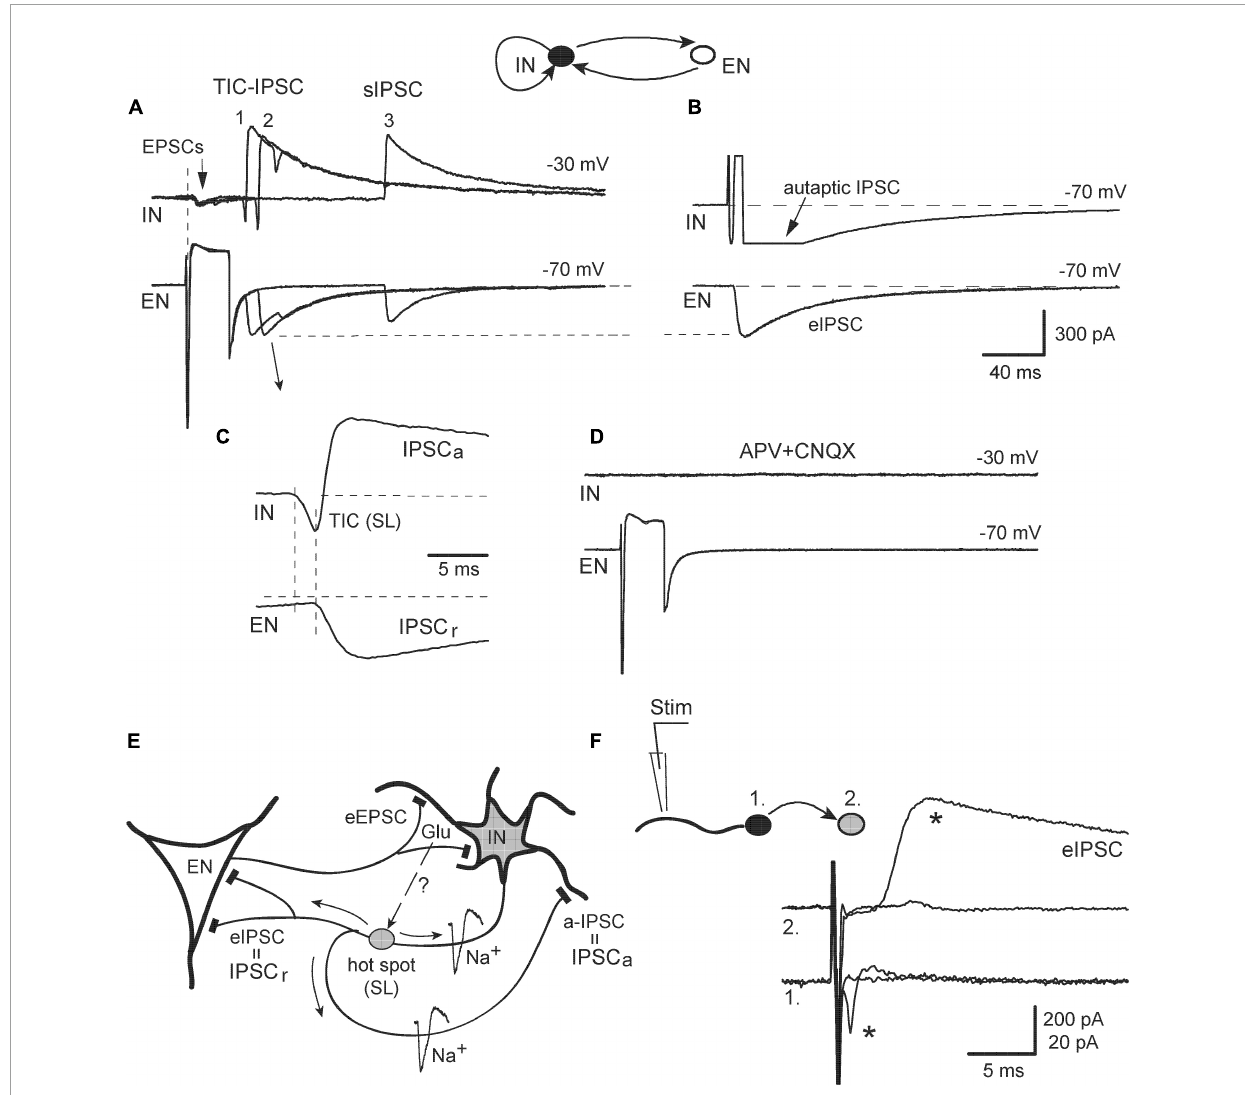
FIGURE7 Example of the electrical behavior of excitatory-inhibitory cell circuit. (A) Presynaptic stimulation of EN induced three kinds of postsynaptic responses (three of them were superimposed): monosynaptic EPSCs ( arrow ), remote sequences TIC-IPSC ( 1 , 2 ), and late sIPSC ( 3 ). (B) Stimulation of IN evoked IPSC in EN and autaptic IPSC in itself (it was blocked by BMI). (C) TIC-IPSC sequence #2 was expanded to show its intrinsic temporal relations (see Text for details). (D) The application of APV + CNQX blocked all responses. (E) Schema describing electrical behavior of EN-IN pair. TICs appeared as local spikelets ( SL ); they originated in axonal hot spots and induced both autaptic IPSC ( a-IPSC ) and eIPSC in EN. Putative signaling of synaptic Glu to axonal iGluR is shown by a dashed arrow and question mark . (F) A test of the active electrical role of the dendrites.